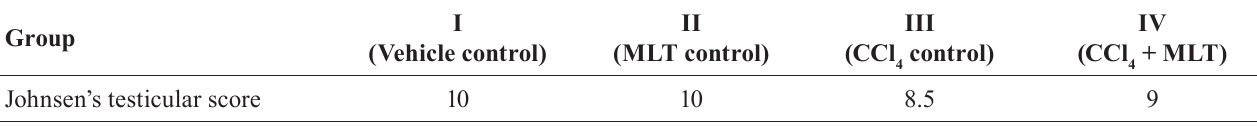
TABLE II - Johnsen’s testicular score estimated for each experimental group